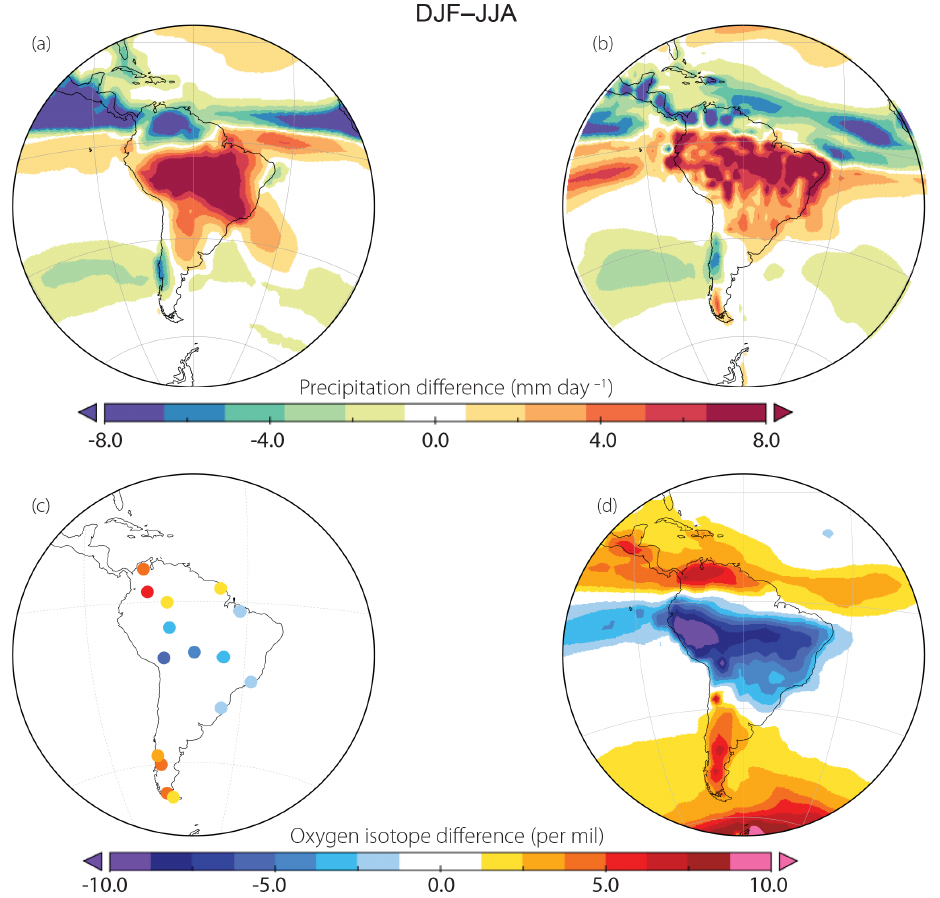
Figure 3. Seasonal cycle (DJF minus JJA) of precipitation in the (a) GPCP precipitation product, from data in Fig. 2, (b) in ModelE2-R, (c) δ 18 O p in GNIP data, and (d) δ 18 O p in ModelE2-R. GNIP data only shown for stations with at least 90 reported δ 18 O p values at a given station from 1960 to present, in addition to at least 10 data values for each month: December, January, February, June, July, and August. Stations with seasonal differences of less than ± 1.0‰ are also omitted in panel (c)